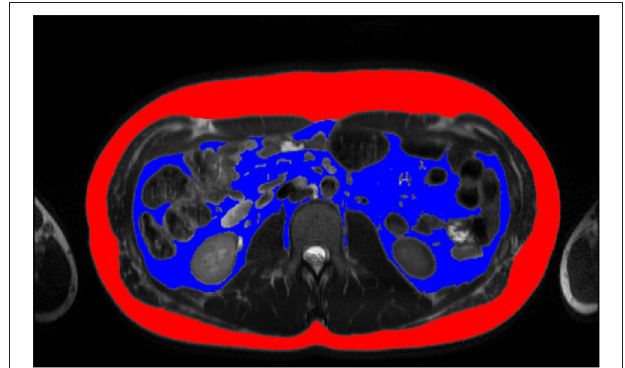
FIGURE 1 | Example of tissue SAT (red) and VAT (blue) segmentation of 14 years old boy, BMI: 27.7 kg/m 2 by MP. BMI, Body Mass Index, MP, second radiologist; SAT, subcutaneous adipose tissue; VAT, visceral adipose